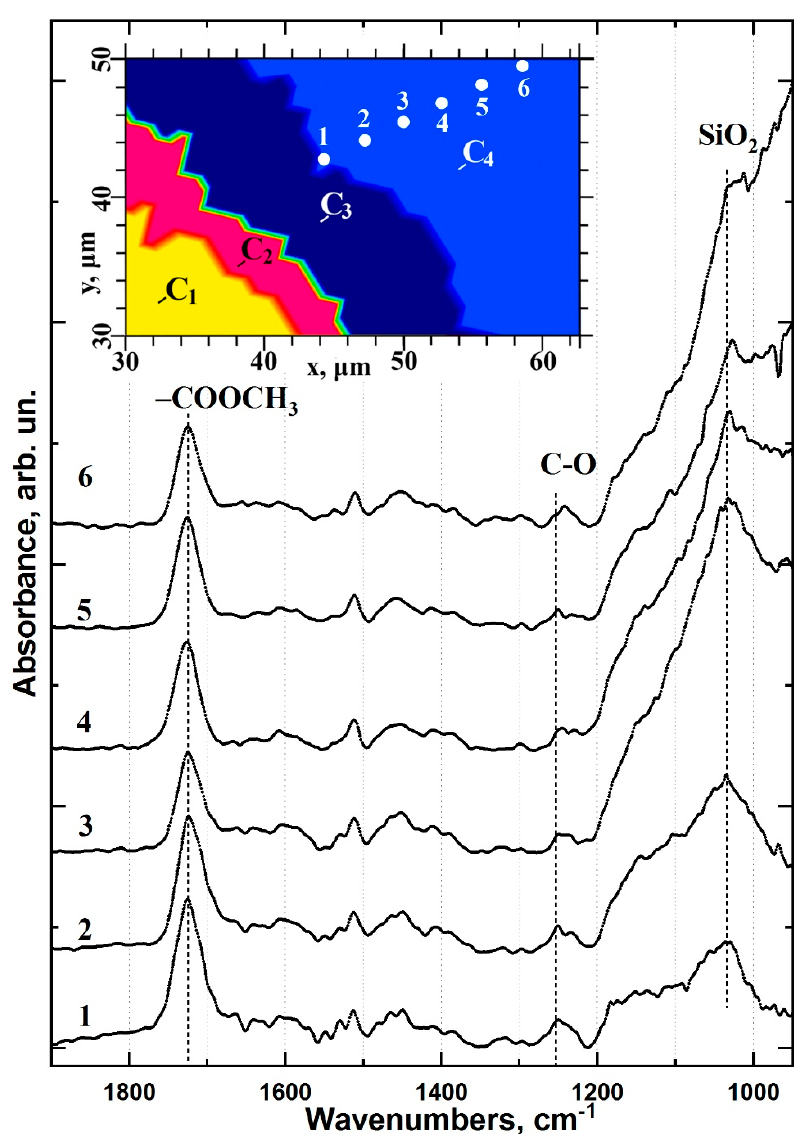
Figure 7. Differential chemical composition in the C 4 (bioprimer and modified adhesive zone) cluster area perpendicular to the type I interface boundary based on FTIR data. (1,2,3,4,5,6) FTIR spectra in points 1,2,3,4,5,6 of C 4 cluster, respectively (insert).